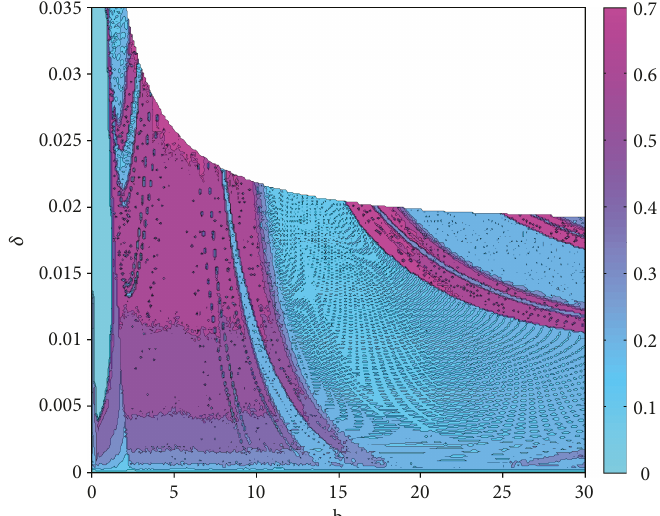
Figure 8: The spectral entropy complexity of system (2) with a = 28 in the b − δ parameter plane.